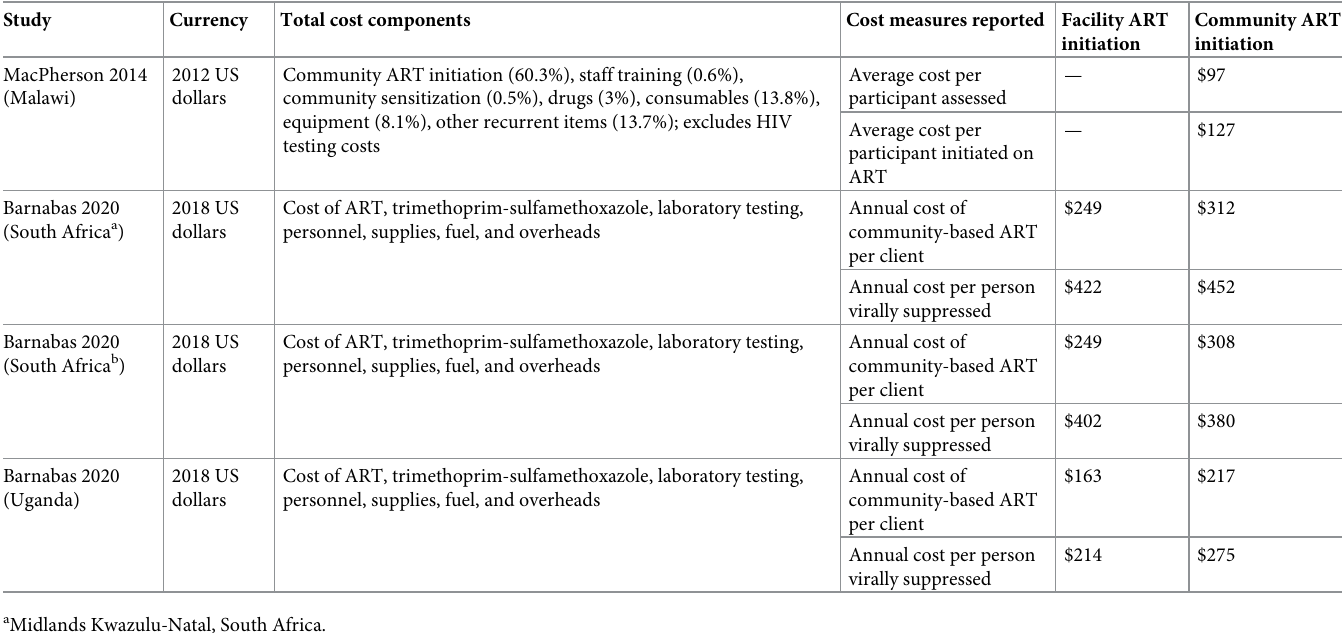
Table 8. Cost analyses reported in included